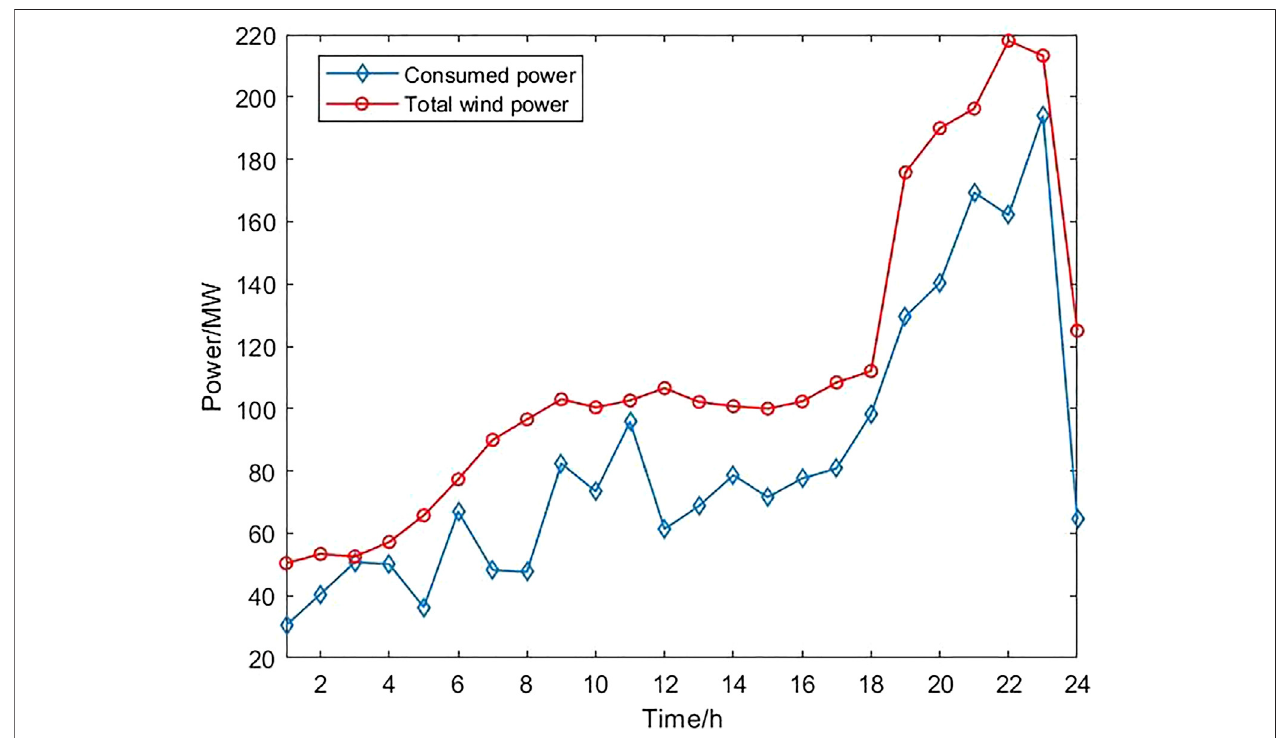
FIGURE 4 | Simulation results of wind power